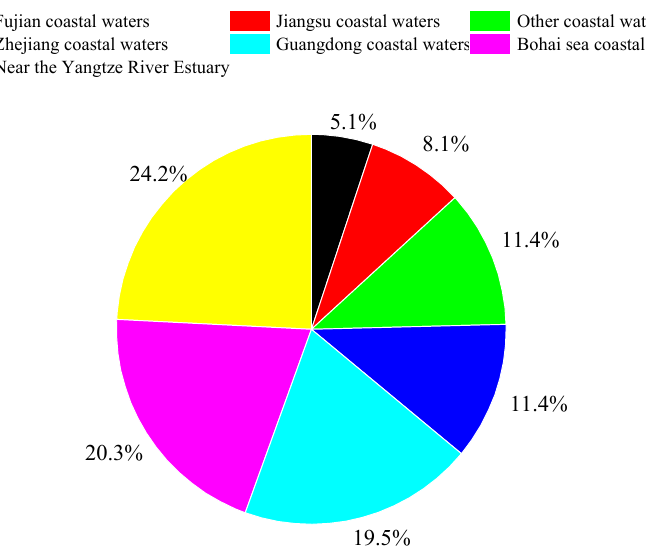
Figure 2. Distribution of marine dumping areas in China in 2021 [23].